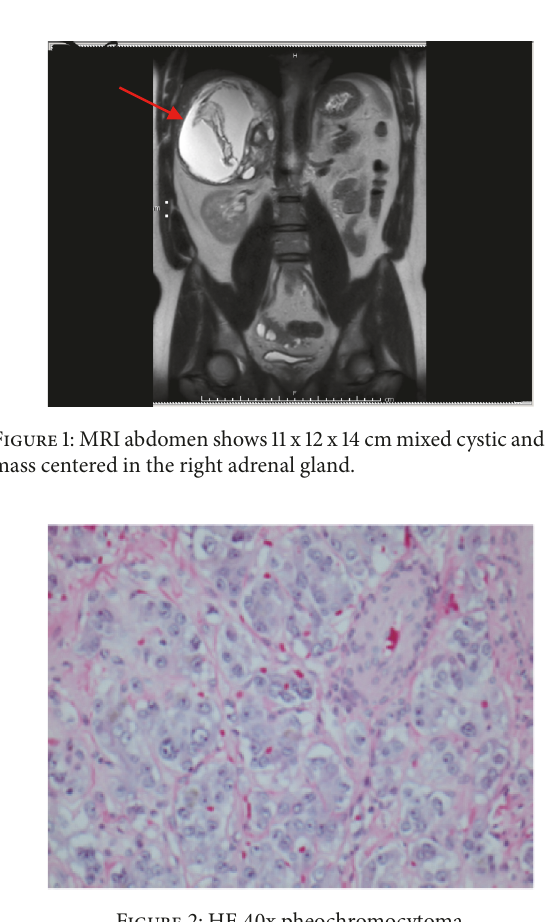
Figure 2: HE 40x pheochromocytoma.